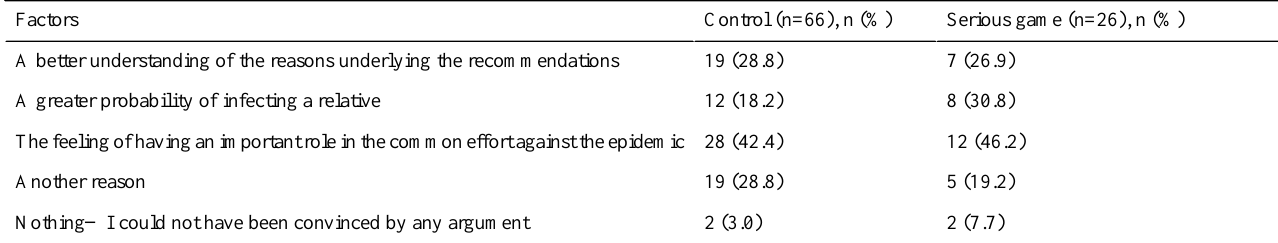
Table 4. Factors that could have brought about a change in infection prevention and control